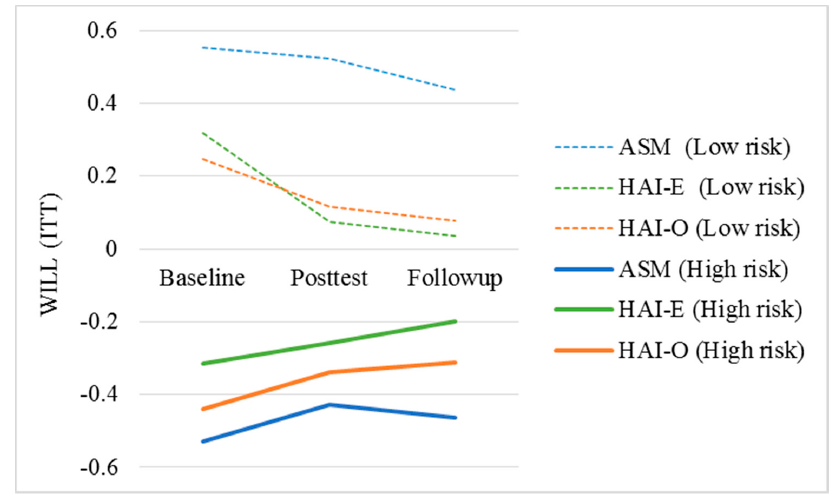
Figure 2. Trajectory of WILL composite scores by treatment condition and risk status. ASM: Stress Management; HAI-E: Human–Animal Interaction Enhanced; HAI-O: Human-Animal Interaction only; ITT: